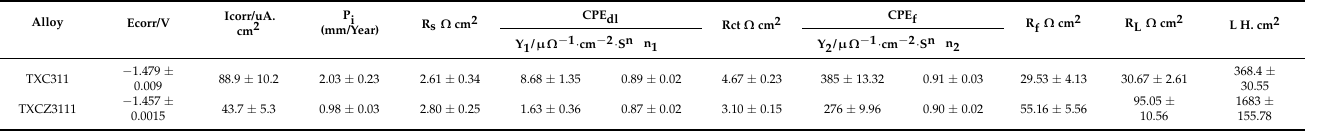
Figure 6. ( a ) Polarization curves; ( b ) Nyquist plots; ( c ) Fitting circuit. Table 2. Polarization curves and impedance fitting results of homogenized TXC311 and TXCZ3111 alloys.